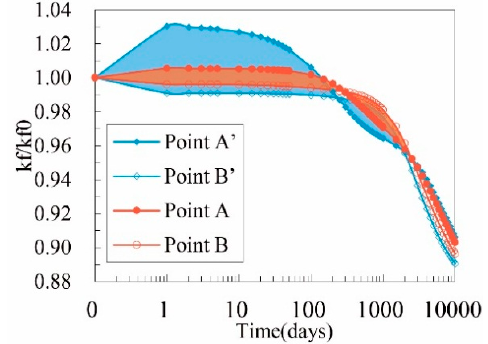
Figure 13. Evolution of matrix permeability at different points.